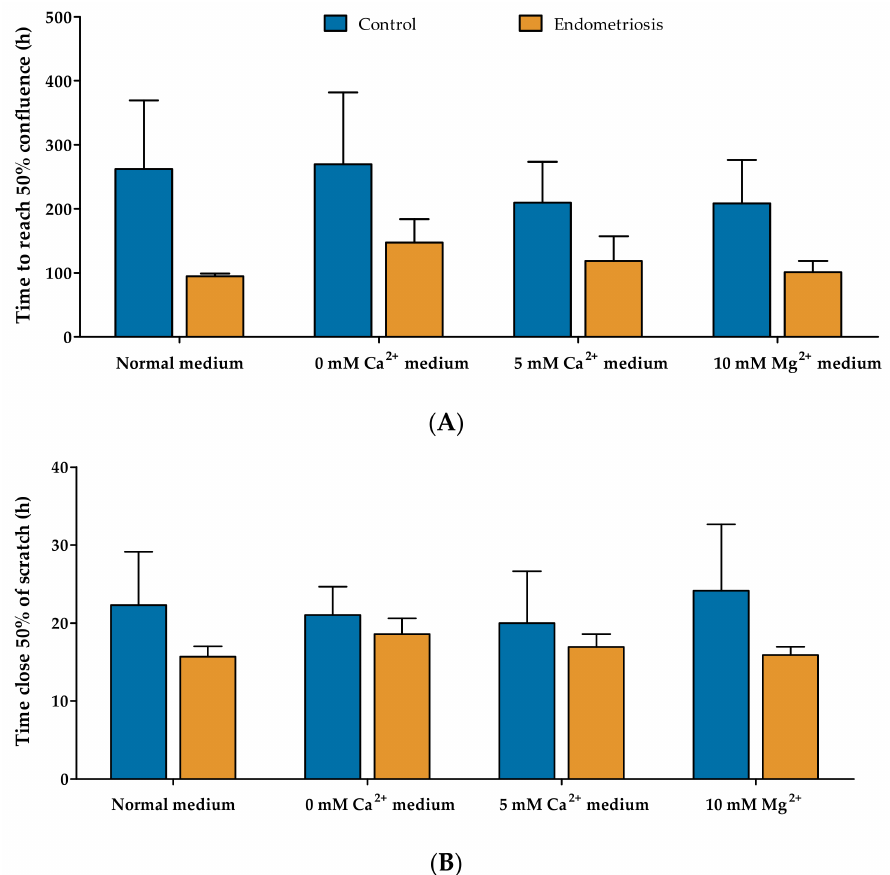
Figure 4. Proliferative and migratory assay of endometriosis-derived hESC. ( A ) The proliferation rate of hESC derived from eutopic endometrium of controls ( n = 4) and endometriosis patients ( n = 4) was assessed by calculating the time taken to reach 50% confluence in the presence of normal medium, 0 mM Ca 2+ , 5 mM Ca 2+ , and 10 mM Mg 2+ ; ( B ) The migratory capacity of hESC derived from endometriosis patients ( n = 4) compared to control hESC ( n = 4). Using the scratch-wound assay,